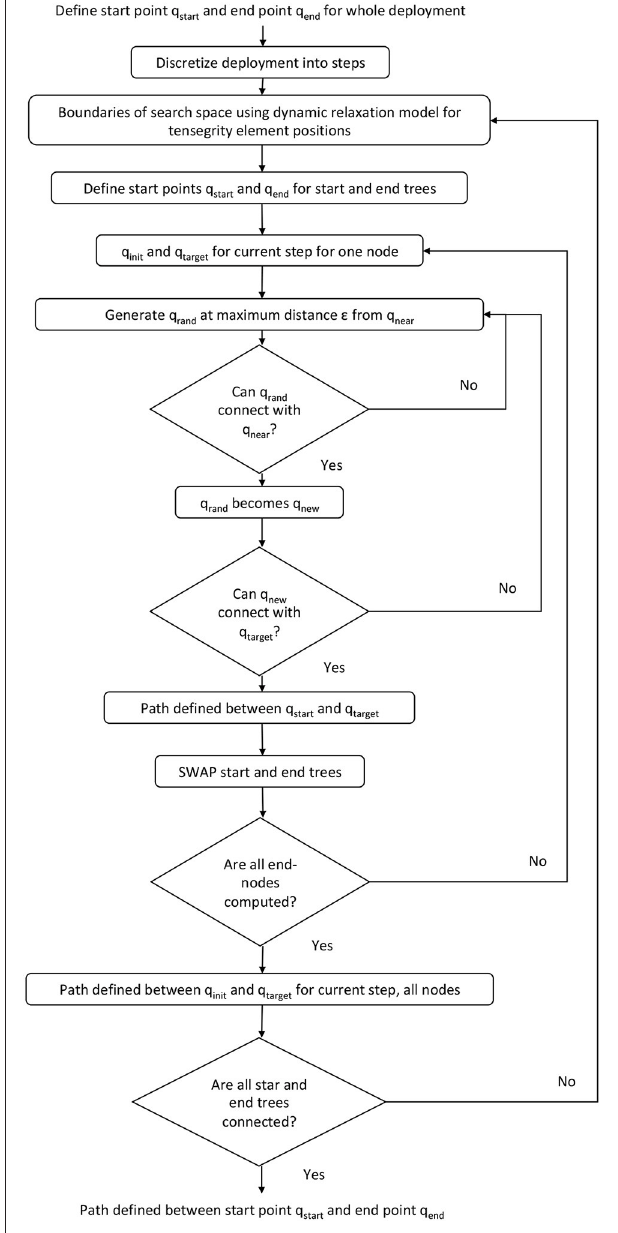
FIGURE 6 | RRT path-planning procedure for movement of the tensegrity structure.